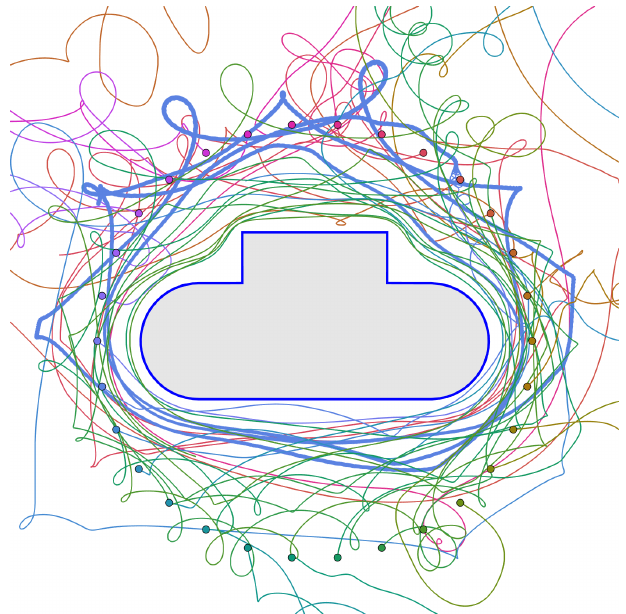
Figure 7. The trajectories of 30 vortices computed with the lightning method. The circulations of the vortices are randomly distributed in the interval [ 1,1 ] . The initial positions of the vortices are − equispaced on a circle, as indicated by the coloured dots. The background flow is set to U =